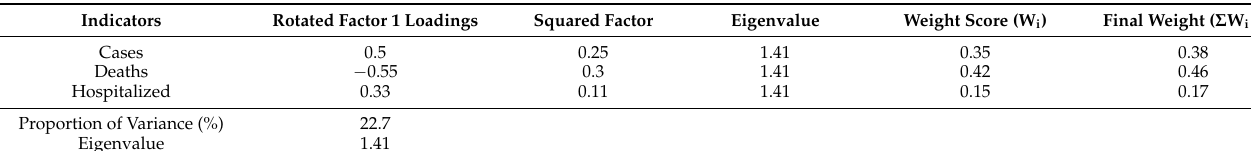
Table 2. Factor analysis results for the exposure subindex.